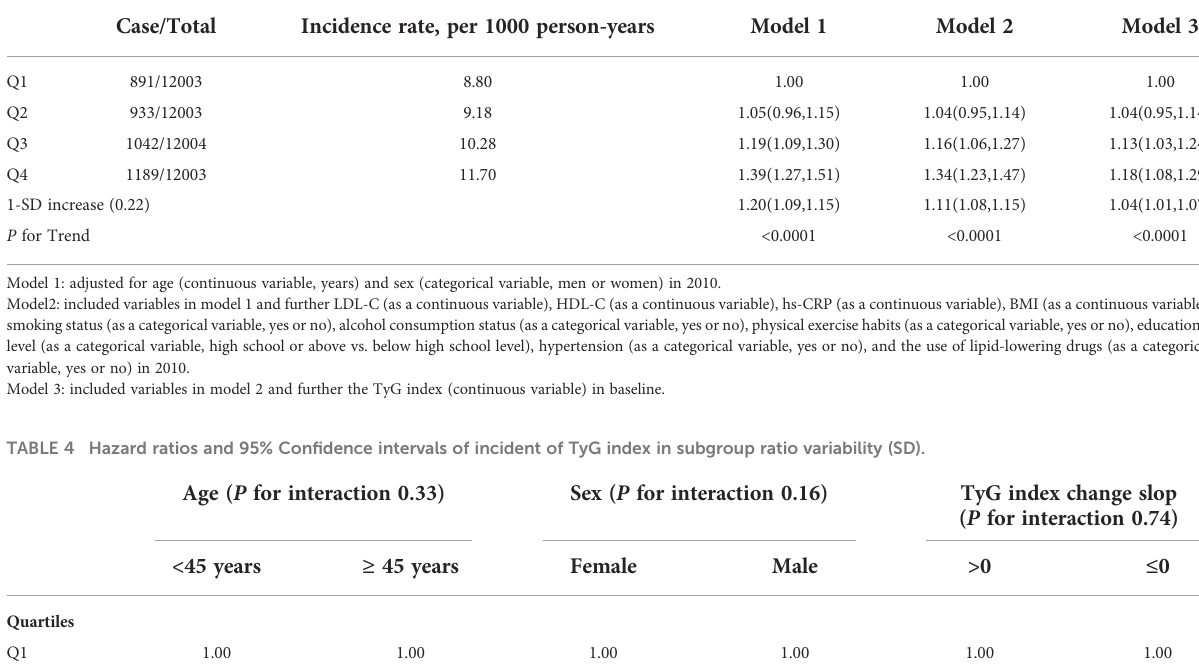
TABLE 3 Hazard ratios and 95% Con fi dence intervals of incident diabetes of TyG index variability